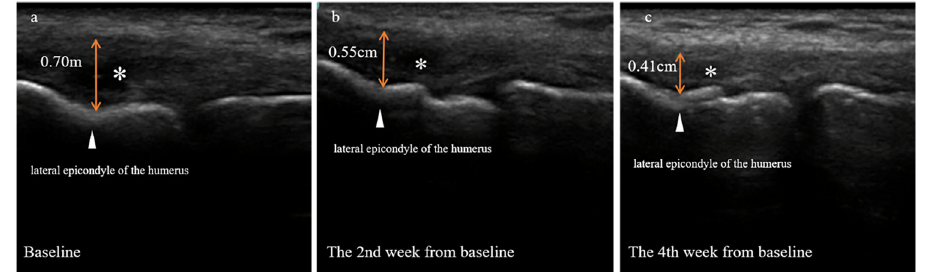
Figure 5. Ultrasound images of the lateral side of the right elbow of a patient with refractory lateral epicondylitis (case two) at baseline ( a ), and two ( b ) or four ( c ) weeks from baseline. The triangle refers to the lateral epicondyle of the humerus. The asterisk denotes the anechoic area formed by the torn extensor tendon. Double-arrowhead solid lines show the thickening of the extensor tendons.